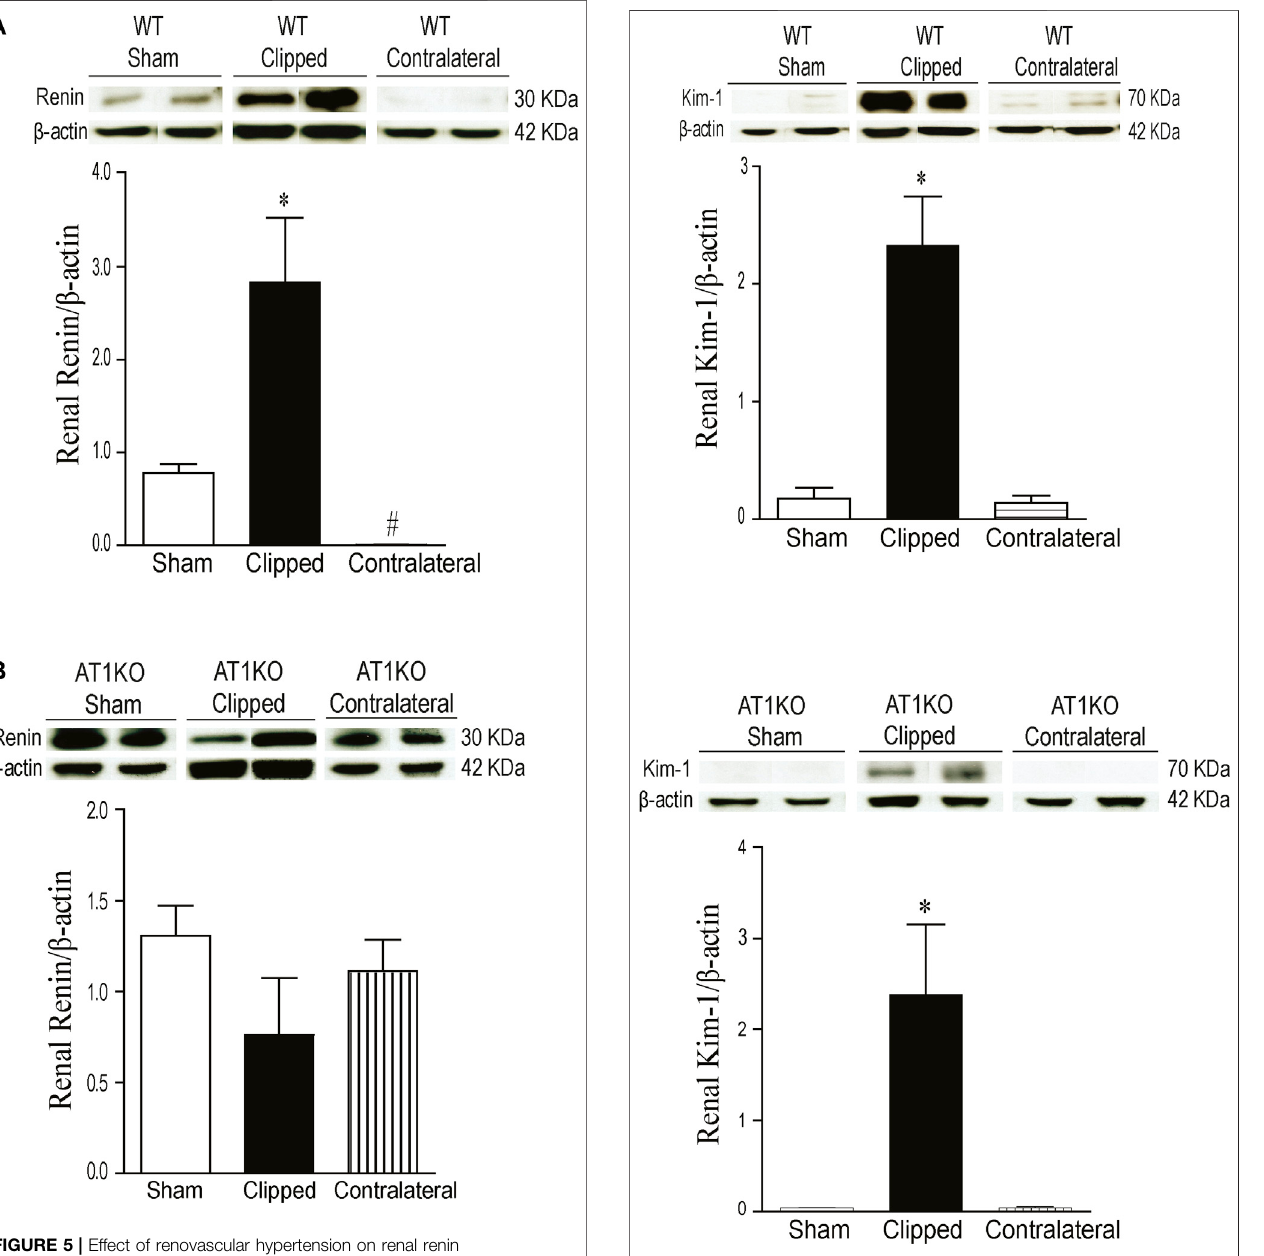
Frontiers in Pharmacology |